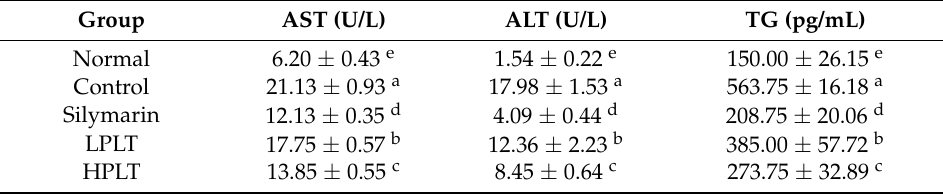
Table 5. Serum aspartate aminotransferase (AST), alanine aminotransferase (ALT), and triglyceride (TG) levels in experimental mice with CCl 4 -induced hepatic damage.